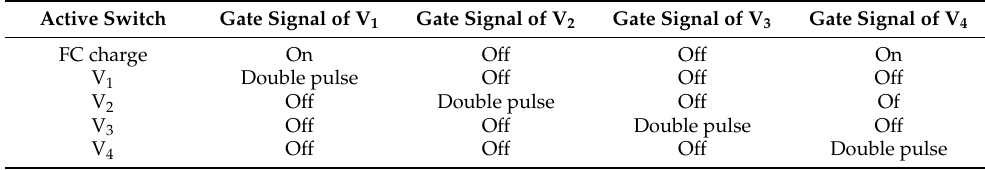
Table 6. Gate signals for double-pulse test for the FC-3L-BDC phase-leg PEBB.